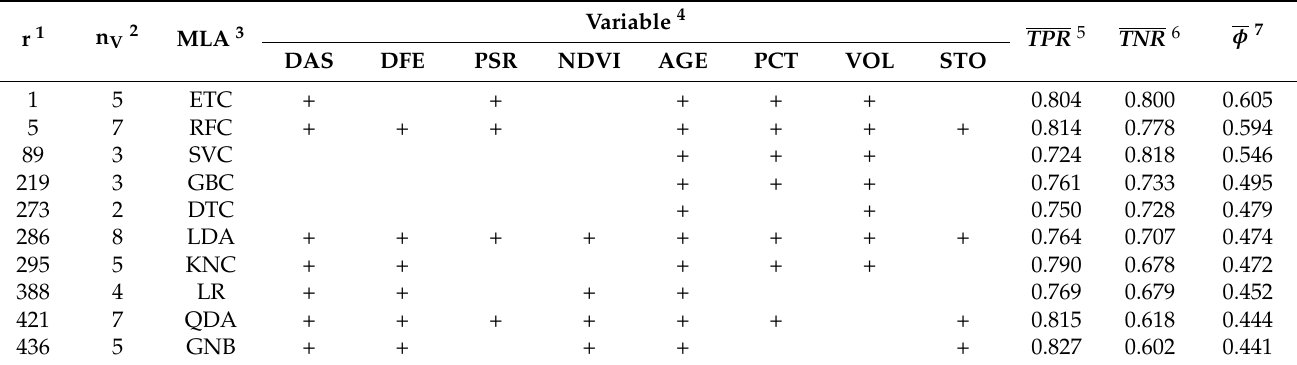
Table 4. Top FDMs generated by machine learning algorithms (MLAs).